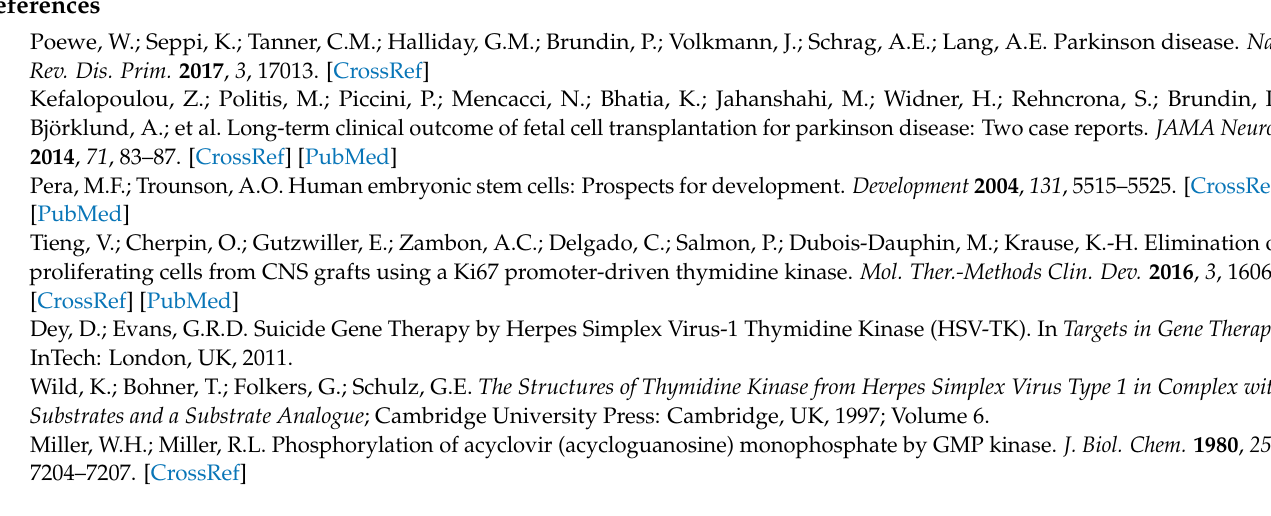
toward neurons, Figure S3: Mice weight, Figure S4: in vivo validation of suicide gene, Figure S5: hESC differentiation toward neurons, Supplementary sequence 1: SR39h and SR39 sequence